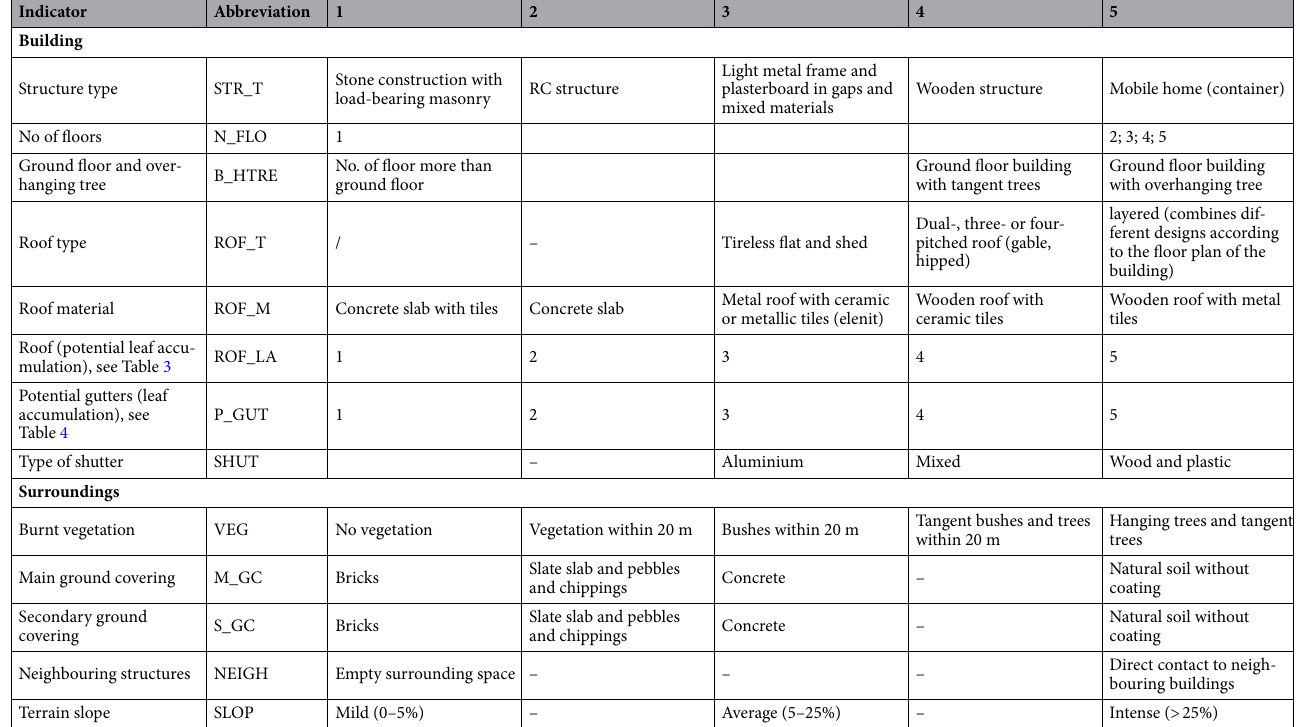
Table 2. The scoring of the indicators collected in the field.